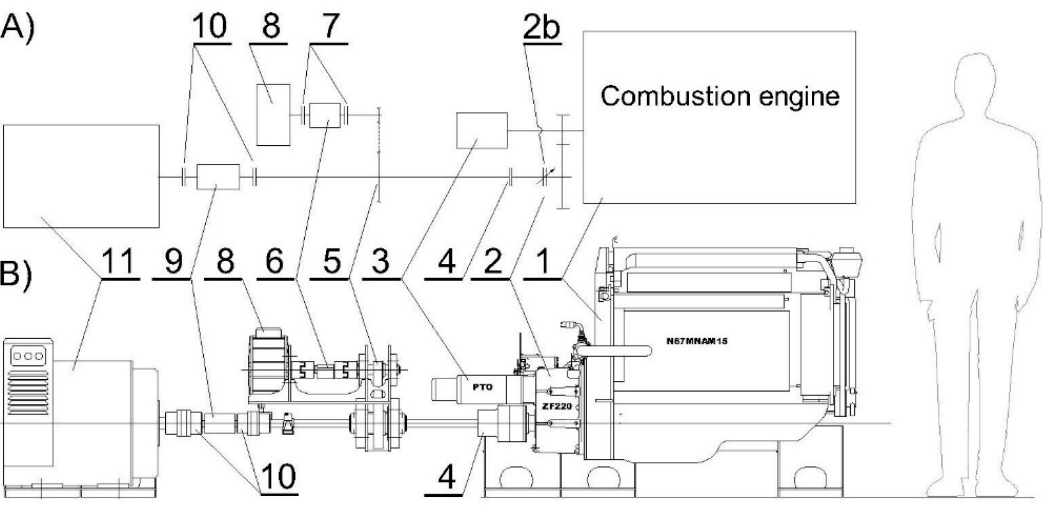
Figure 4. Test stand for hybrid drive; ( A ) simplified schematic diagram, ( B ) assembly drawing; 1—combustion engine, 2—reduction gear with integrated controlled clutch (2b), 3—hydraulic pump for loading the main engine, 4, 7, 10—clutches, 5—electric drive gear reduction belt, 6, 9—torque gauges, 8—electric motor, 11—electric generator-load.